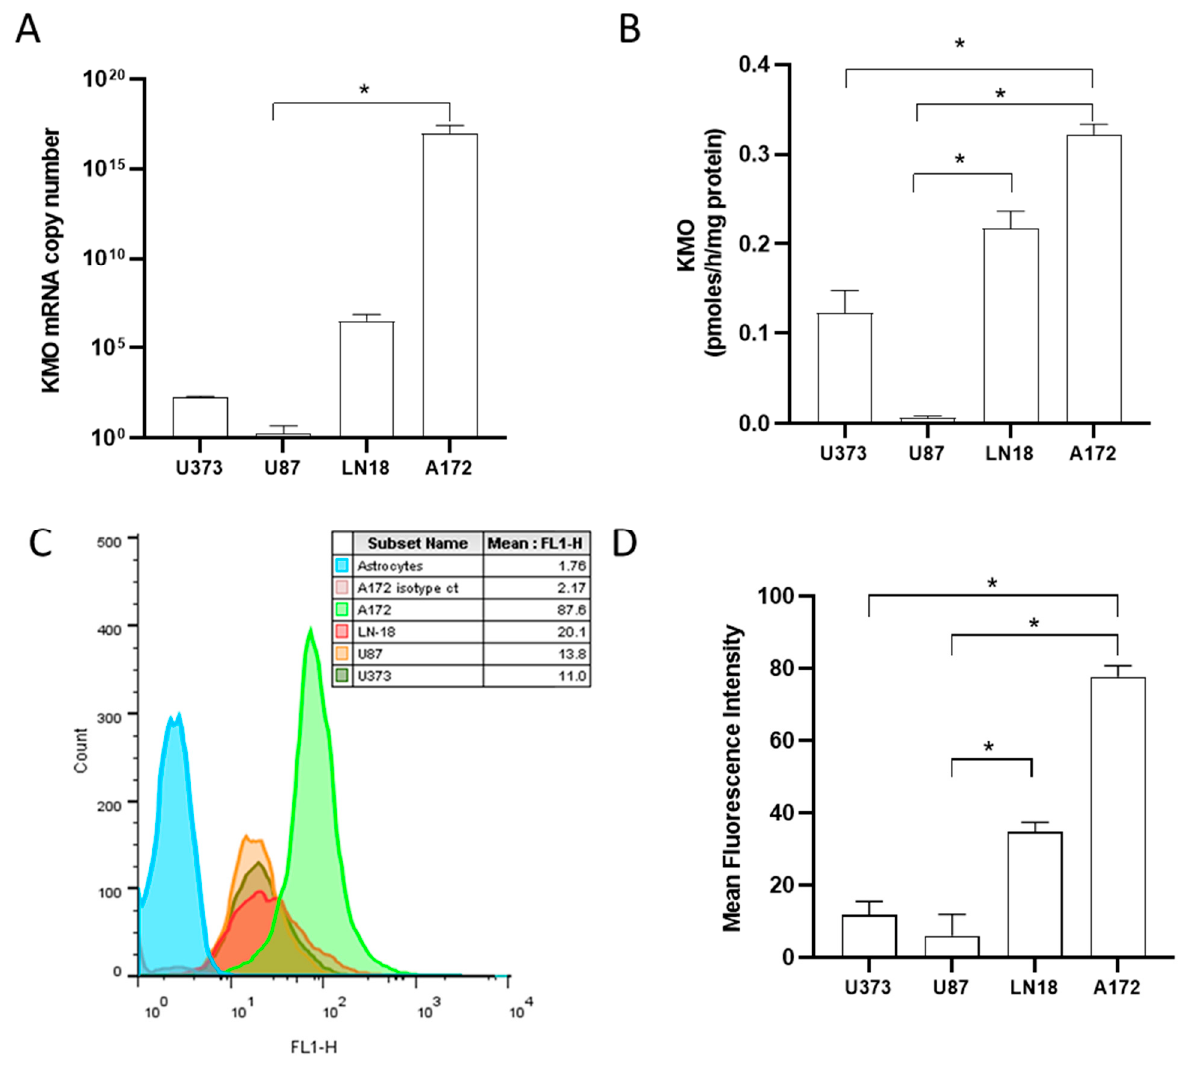
Figure 1. Kynurenine monooxygenase expression and activity in GBM cell lines. Quantification of KMO mRNA copies ( A ) and KMO activity ( B ) in GBM cell lines A172, LN-18, U87, and U373. Representative histogram ( C ) and KMO protein expression in GBM cell lines ( D ). Data in ( A , B , D ) are the mean ± SEM ( n = 3–5); * p < 0.05 based on the Kruskal–Wallis test, with Dunn’s test for pairwise comparisons.